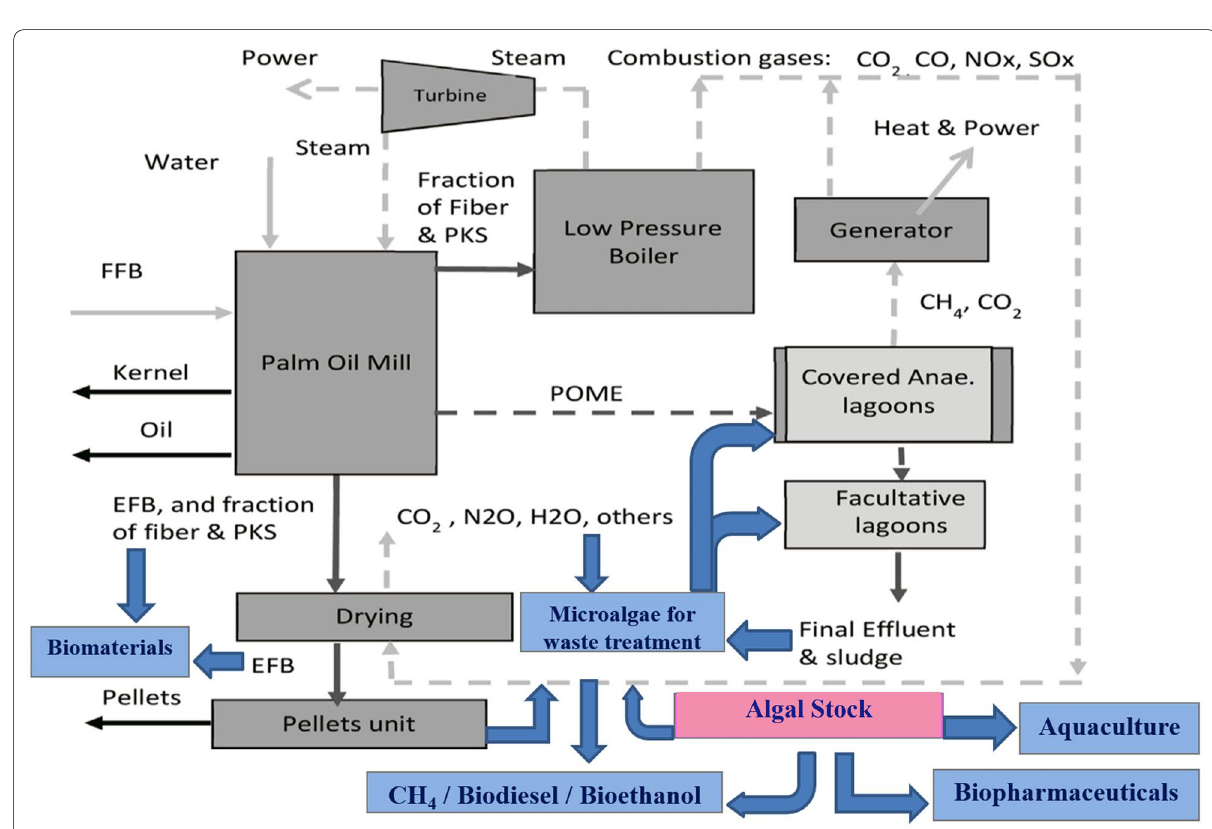
Fig. 6 The integrated algal and oil palm biorefinery (modified from Garcia-nunez et al. 2016; Abdullah and Hussein